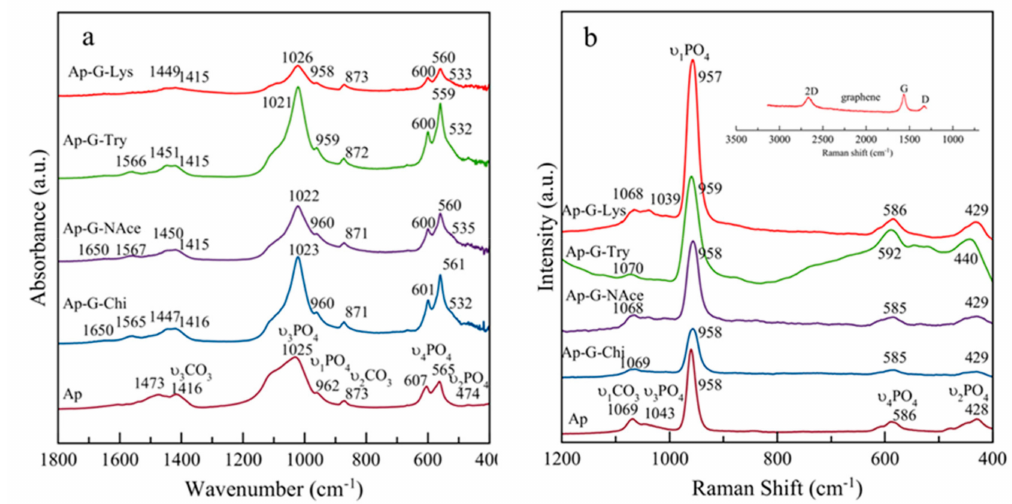
Figure 3. ( a ) FTIR spectra and ( b ) Raman spectra of nanocrystalline apatites nucleated by the